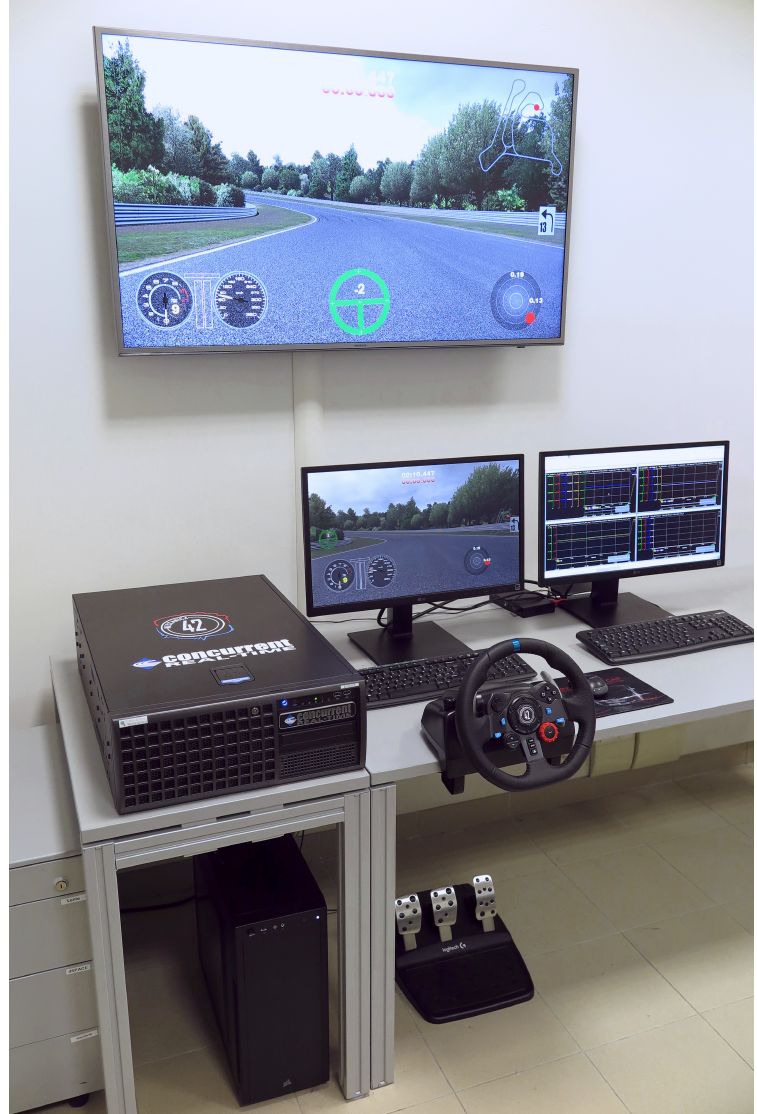
Figure 7. Hardware-in-the-loop real-time car